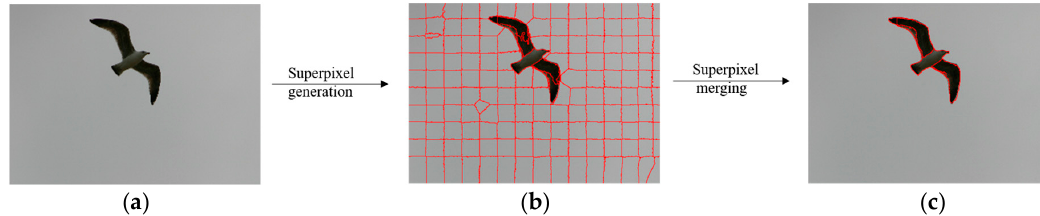
Figure 2. Illustration diagram of the superpixel merging algorithm: ( a ) the original image, ( b ) the superpixel generated image, ( c ) the superpixel merged into image patches image.